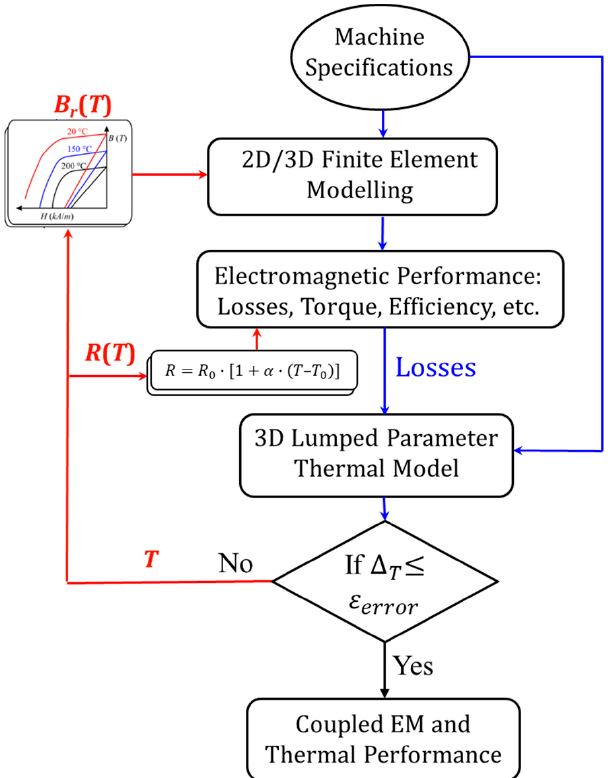
Figure 2. Flowchart of the coupled EM–thermal modelling. T , B r , R , and ε error are the temperature, magnet remanence, phase resistance, and convergence error, respectively. Table 1. Parameters of modular SPM machine.